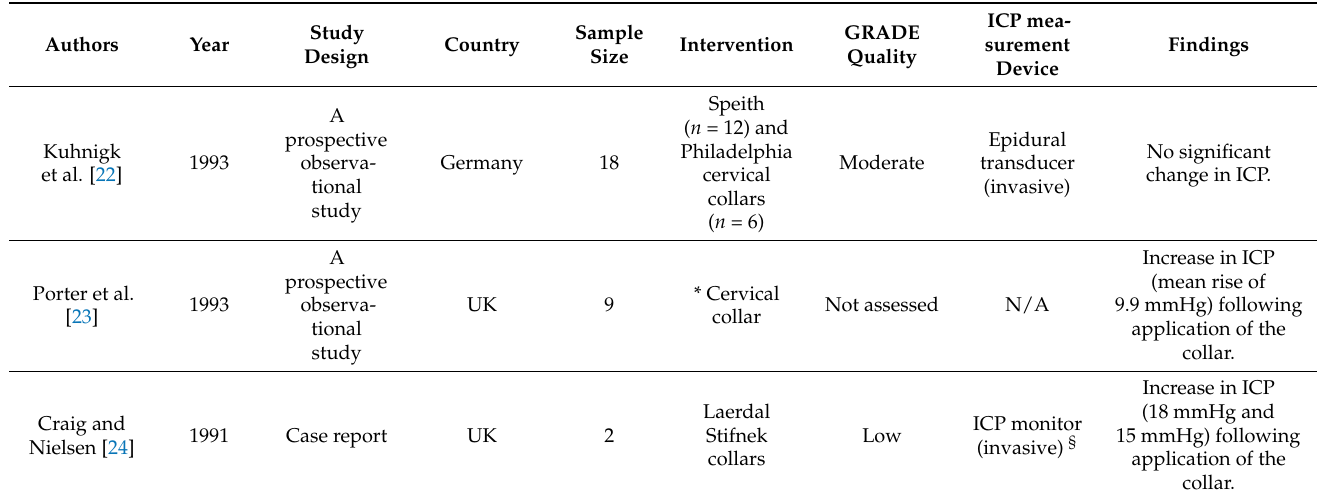
Table 3. Characteristics of the additional studies identified from the systematic search but were outside our inclusion/exclusion